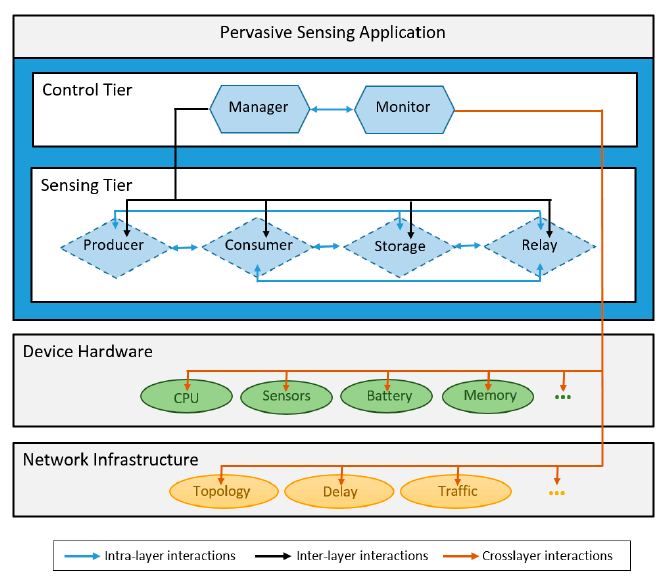
Figure 2. Architecture of the MASU Framework.